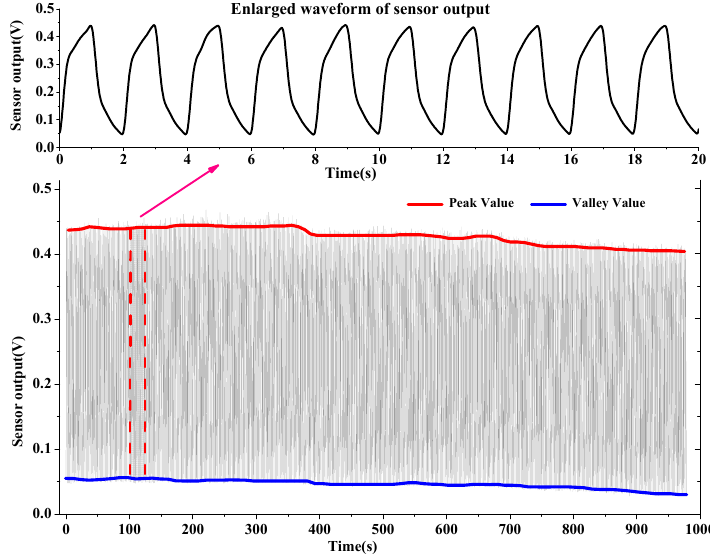
Figure 5. Measurements on alternating airflow mimicking respiratory fluctuation in moist air.